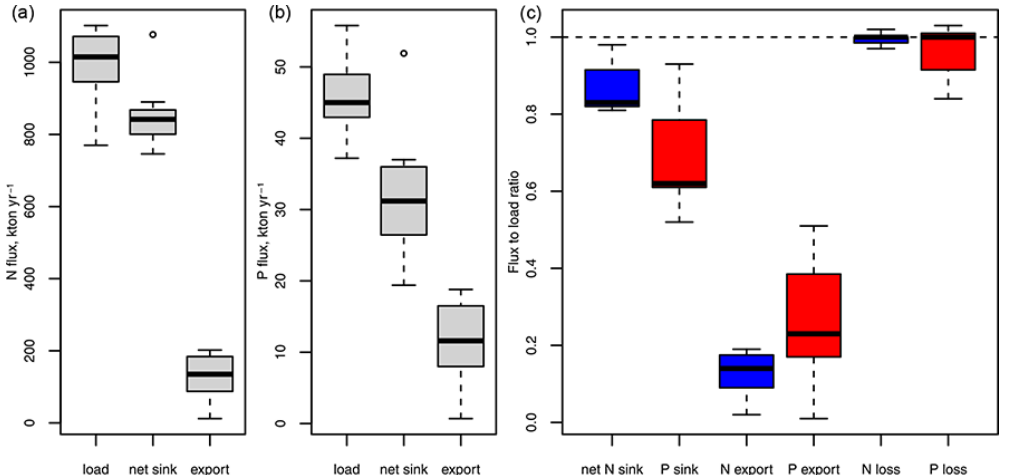
Figure 4. Nitrogen (a) and phosphorus (b) fluxes corresponding to nutrient budgets published for 1971–2018 (Gustafsson et al., 2012, 2017; Liu et al., 2017; Savchuk, 2005, 2018; Savchuk and Wulff, 2007; Schneider et al., 2017). Panel (c) shows ratios between sinks, exports, and total loss as a sum of sinks and export to external inputs. Box and whiskers show the distribution of the seven flux estimates. Boxes enclose 25%–75% percentiles and whiskers the non-outlier